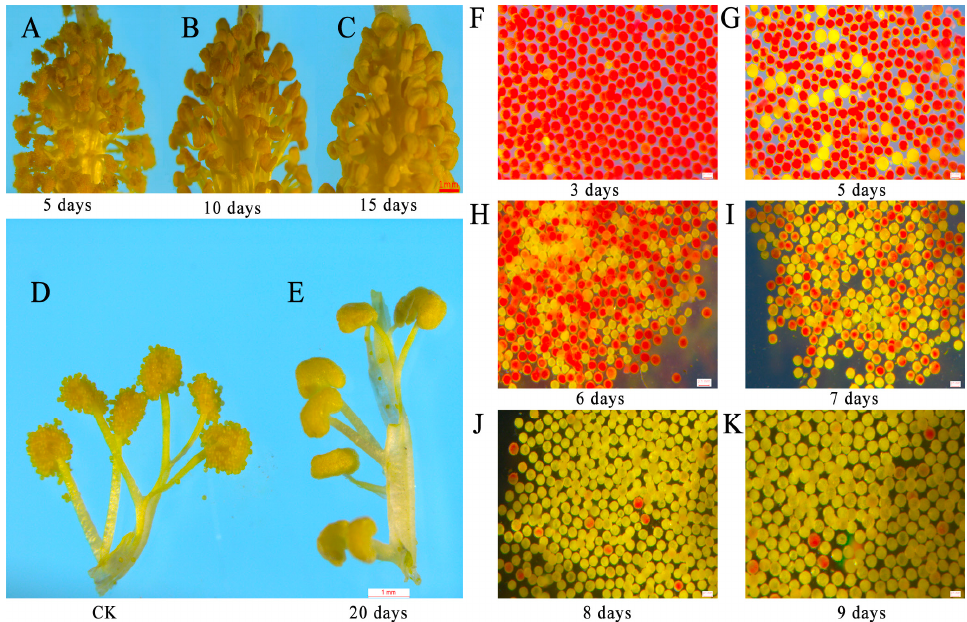
Figure 4. The effect of glyphosate on the anther dehiscence and pollen grain viability. ( A – C ) The anthers were treated with 15 g/L glyphosate for 5 days ( A ), 10 days ( B ), and 15 days ( C ); ( D ) the anthers were treated with water for 20 days; ( E ) the anthers were treated with 15 g/L glyphosate for 20 days; ( F – K ) the pollen grains treated with 15 g/L glyphosate for 3 days ( F ), 5 days ( G ), 6 days ( H ), 7 days ( I ), 8 days ( J ), 9 days ( K ). ( A – E ) The scale bars are 1 mm. ( F – K ) The scale bars are 0.1 mm.